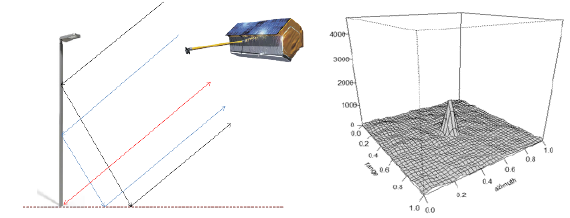
Figure 3. Metal pole and combination of reflections